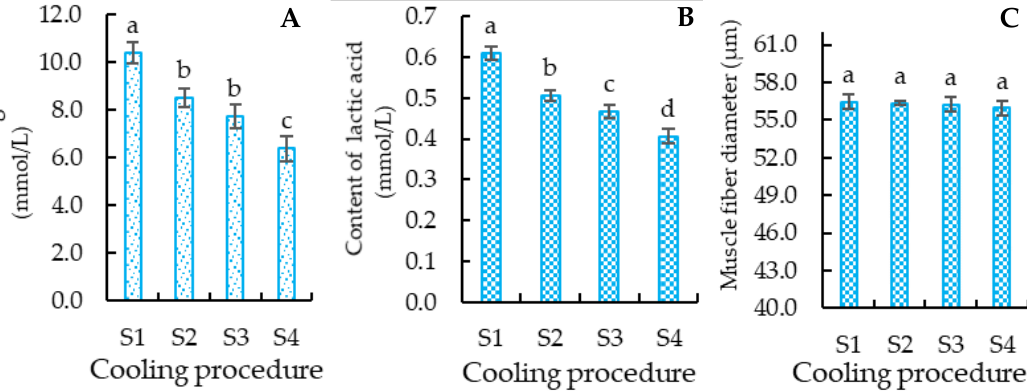
Figure 5. Effects of cooling speed on content of blood glucose ( A ), lactic acid ( B ), and the muscle fiber diameter ( C ) of the crucian carp. S1: treated with cooling speed of 5 °C/h followed by 1 °C/h; S2: treated with cooling speed of 3 °C/h followed by 1 °C/h; S3: treated with cooling speed of 2 °C/h followed by 1 °C/h; S4: control. Different letters beside the standard deviation represent significant differences between the groups ( p < 0.05).